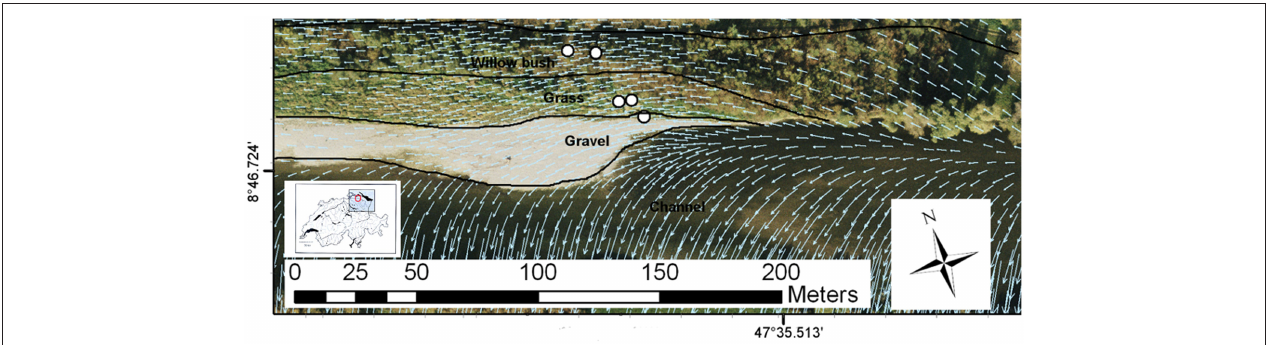
FIGURE 1 | Field site at Niederneunforn, Switzerland with installed piezometers in the restored section of the River Thur with the different functional process zones indicated (piezometers selected for this study are highlighted). Overlaid arrows indicate the groundwater flow direction (Peter et al., 2012b). River water directly infiltrates in the different riparian